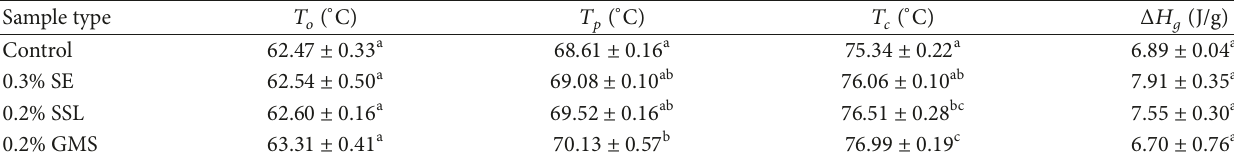
Table 1: Gelatinization properties of rice gels with different emulsifiers (means ± SE).